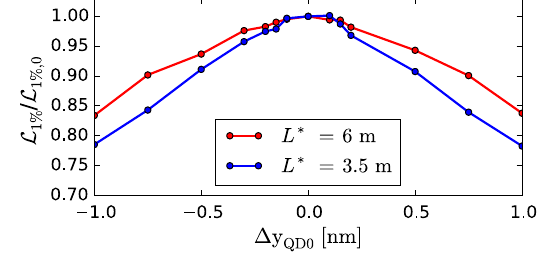
FIG. 11. QD0 vertical offset scan as a function of the relative